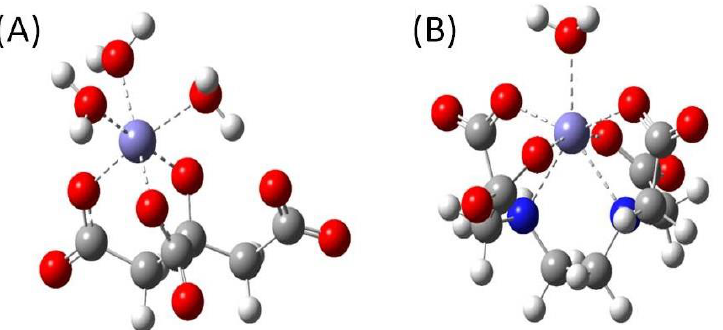
Figure 10. Optimized geometries of ( A ) Cit and ( B ) EDTA complexes with Fe(III) and water molecules.